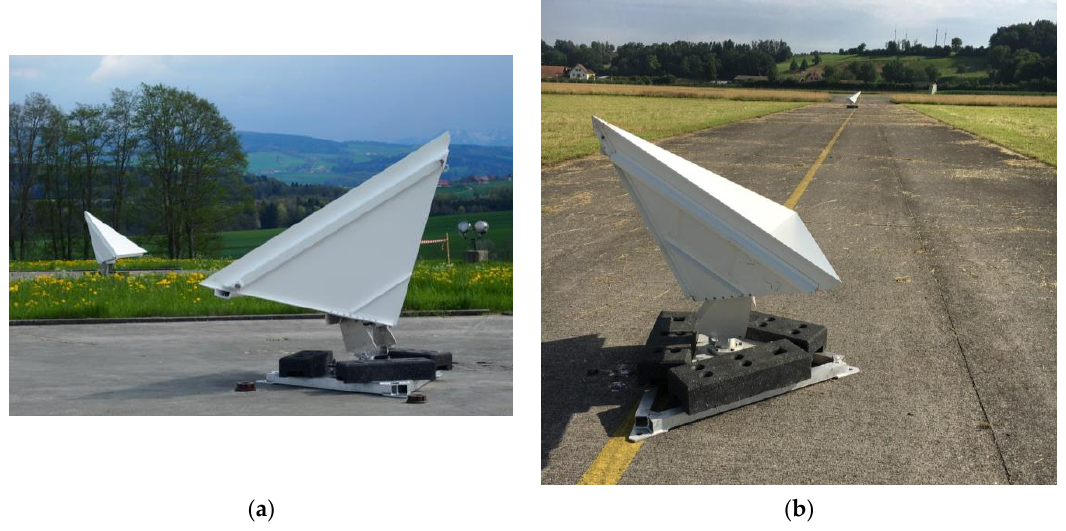
Figure 1. Trihedral corner reflectors at test sites in Switzerland, used for Sentinel-1B’s (S-1B) calibration as well as Sentinel-1A/B product validation; ( a ) 1.5 m reflectors near Torny-le-Grand ; ( b ) 1.0 m (foreground) and 1.2 m reflectors (background) near Dübendorf.